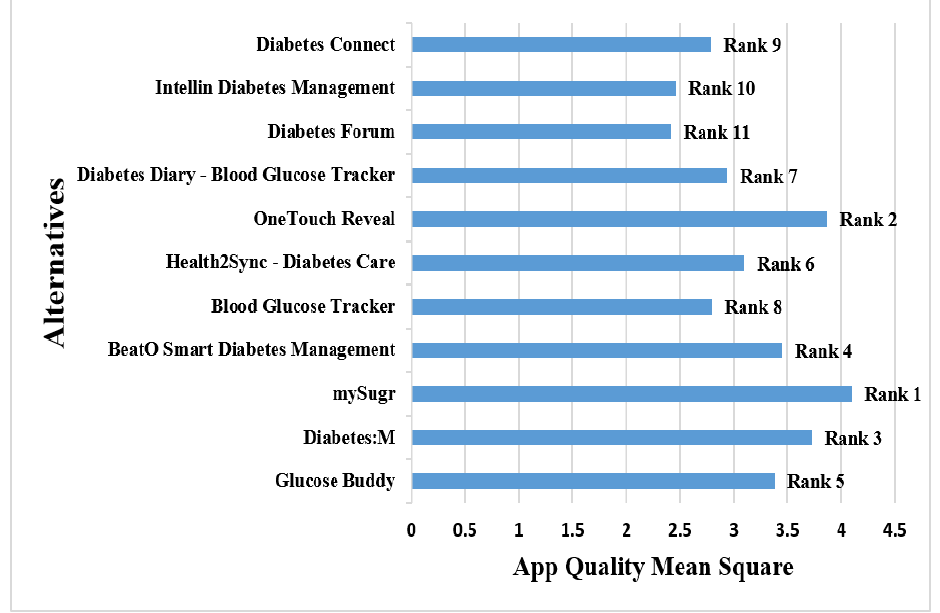
Figure 5. Rank of the applications based on the Application Quality Mean Score.